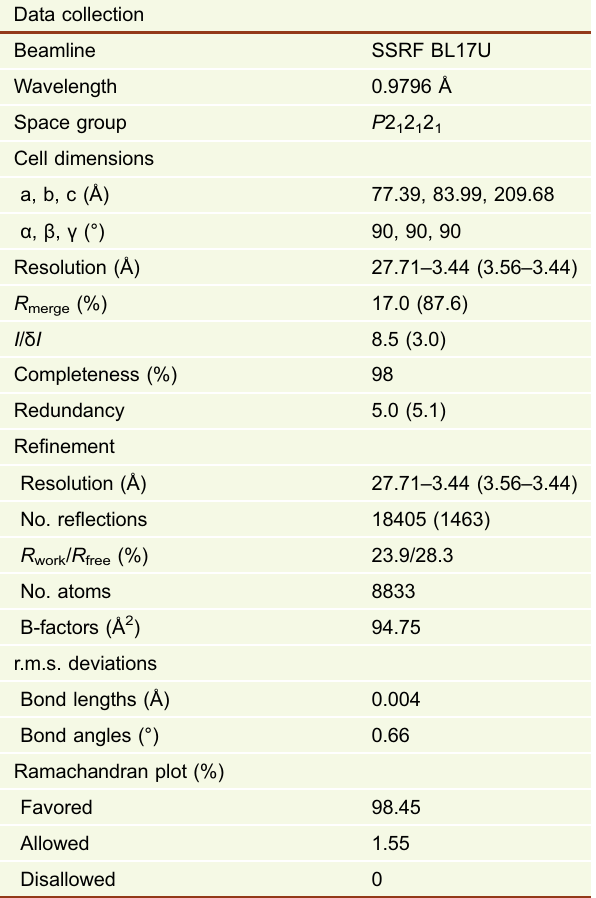
Table 1. Crystal diffraction data collection and structural re fi nement